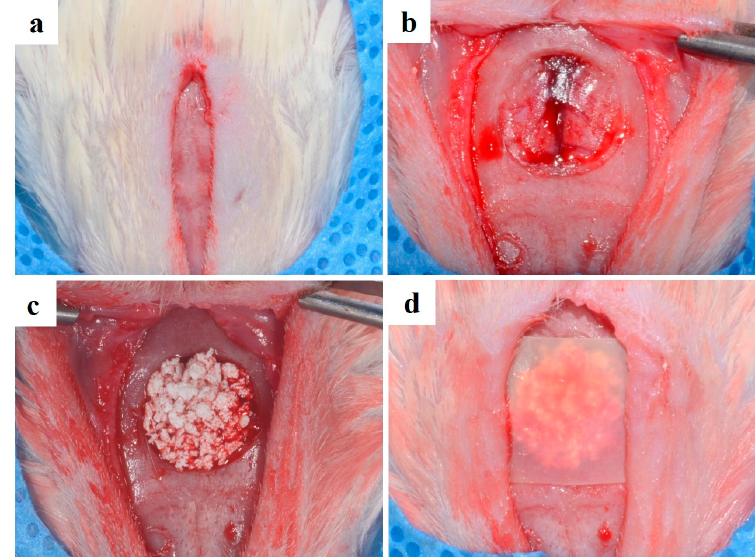
Figure 8. Operative procedure ( a ) full-thickness flap; ( b ) calvarial defect preparation using the 8 mm trephine bur; ( c ) bone graft material placement; ( d ) BC membrane placement. trephine bur; ( c ) bone graft material placement; ( d ) BC membrane